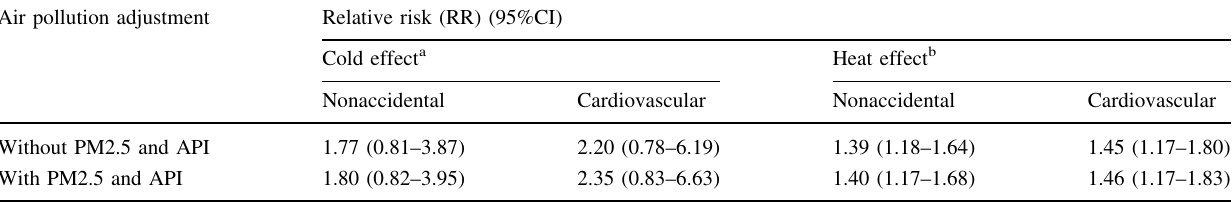
Table 4 Comparison of heat and cold effects with and without including PM2.5 and API in the temperature–mortality model of Beijing